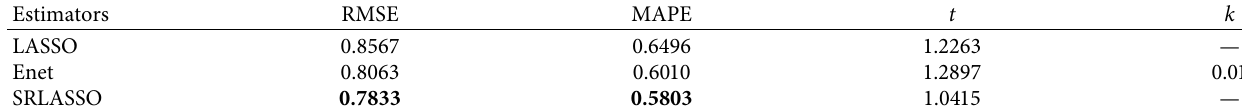
Table 2: Cross-validated RMSE and MAPE values of Prostate Cancer